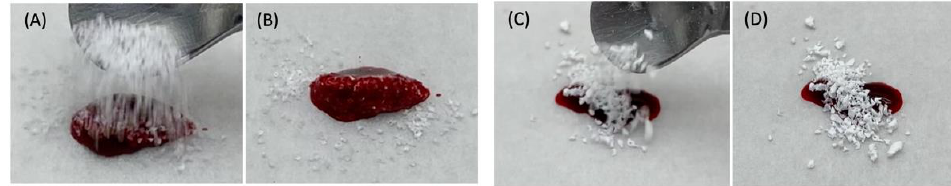
Figure 3. Comparison of wicking property between InRoad ( A , B ) and Bio-Oss ( C , D ) using fresh rat blood. Superior wicking property was demonstrated on InRoad compare to that of Bio-Oss.